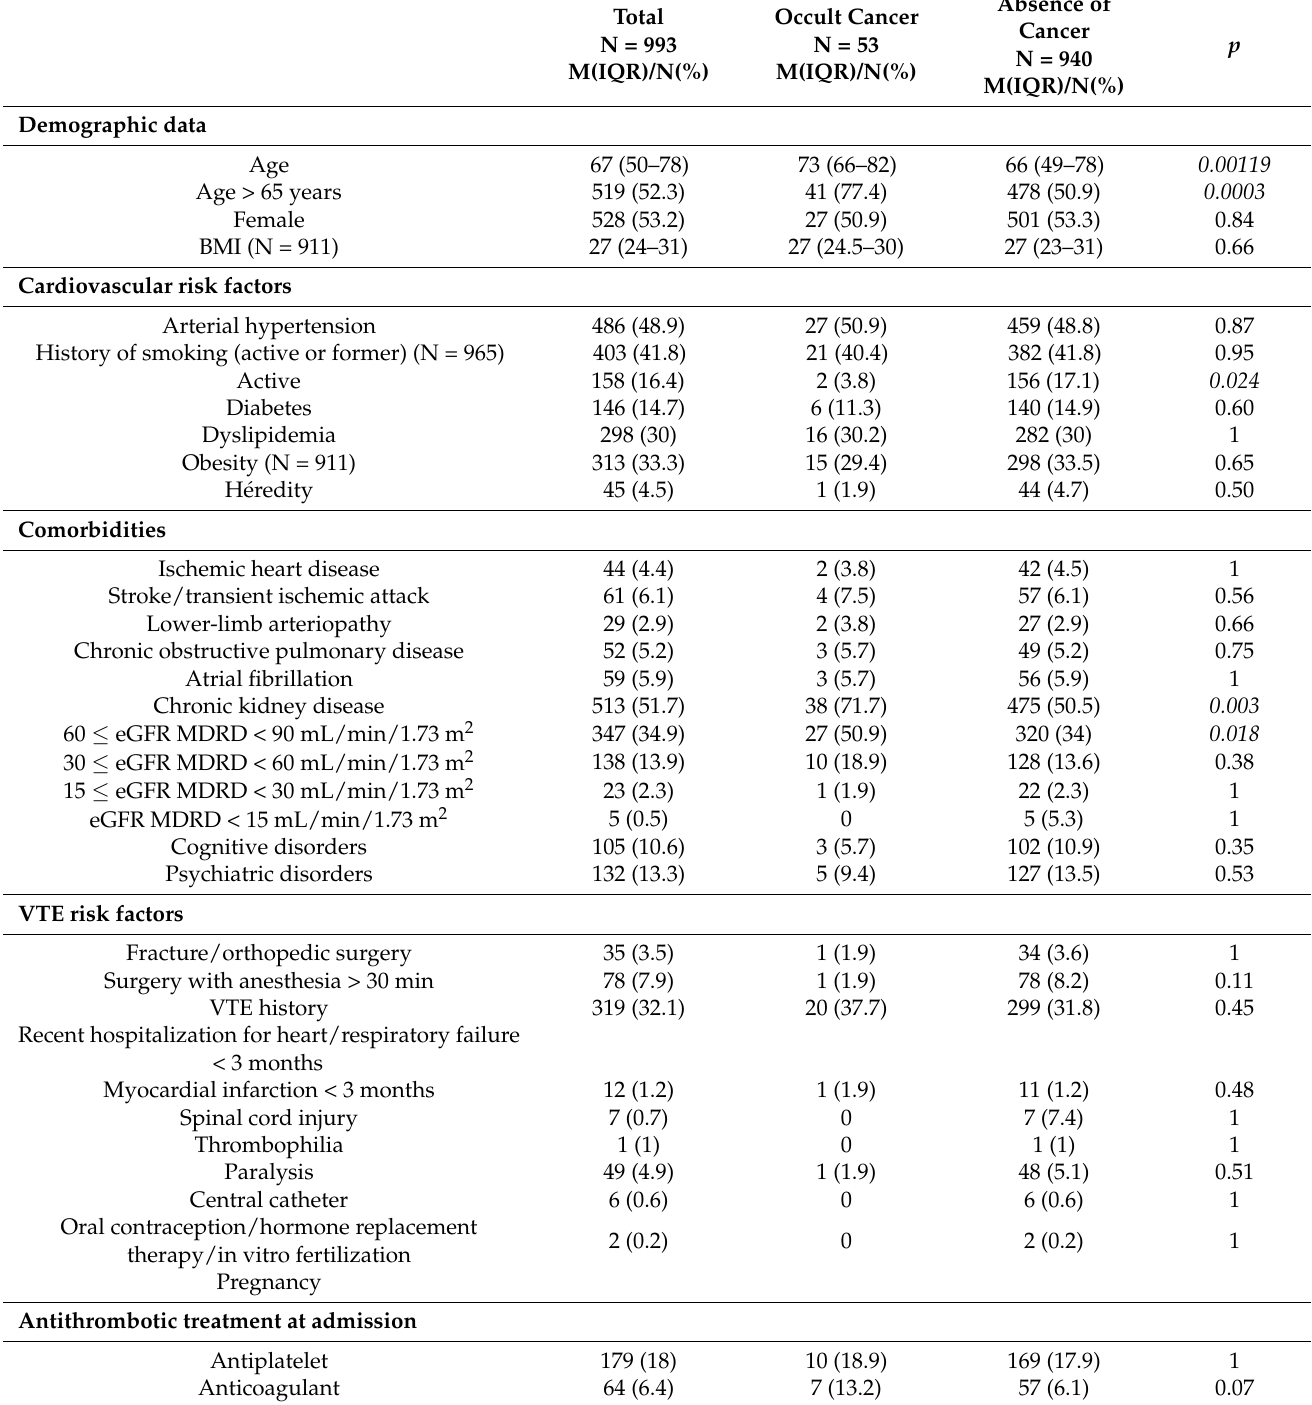
Table 1. Baseline characteristics according to occult cancer